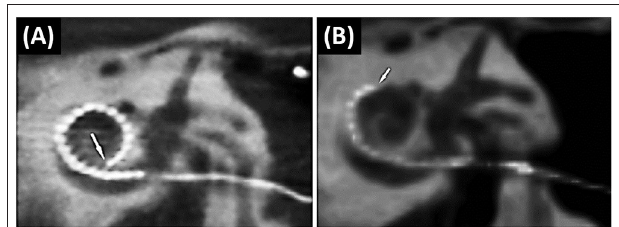
FIGURE 5 | The immediate post-operative CT scan shows a fully inserted Cochlear Slim Straight array (CI422) with an insertion angle of 390 ◦ (A) . The follow-up scan shows a substantially retracted electrode with six extra-cochlear electrodes and an insertion angle of 210 ◦ . The arrow points to the tip of the electrode (21) (B) . Reproduced by permission of Springer